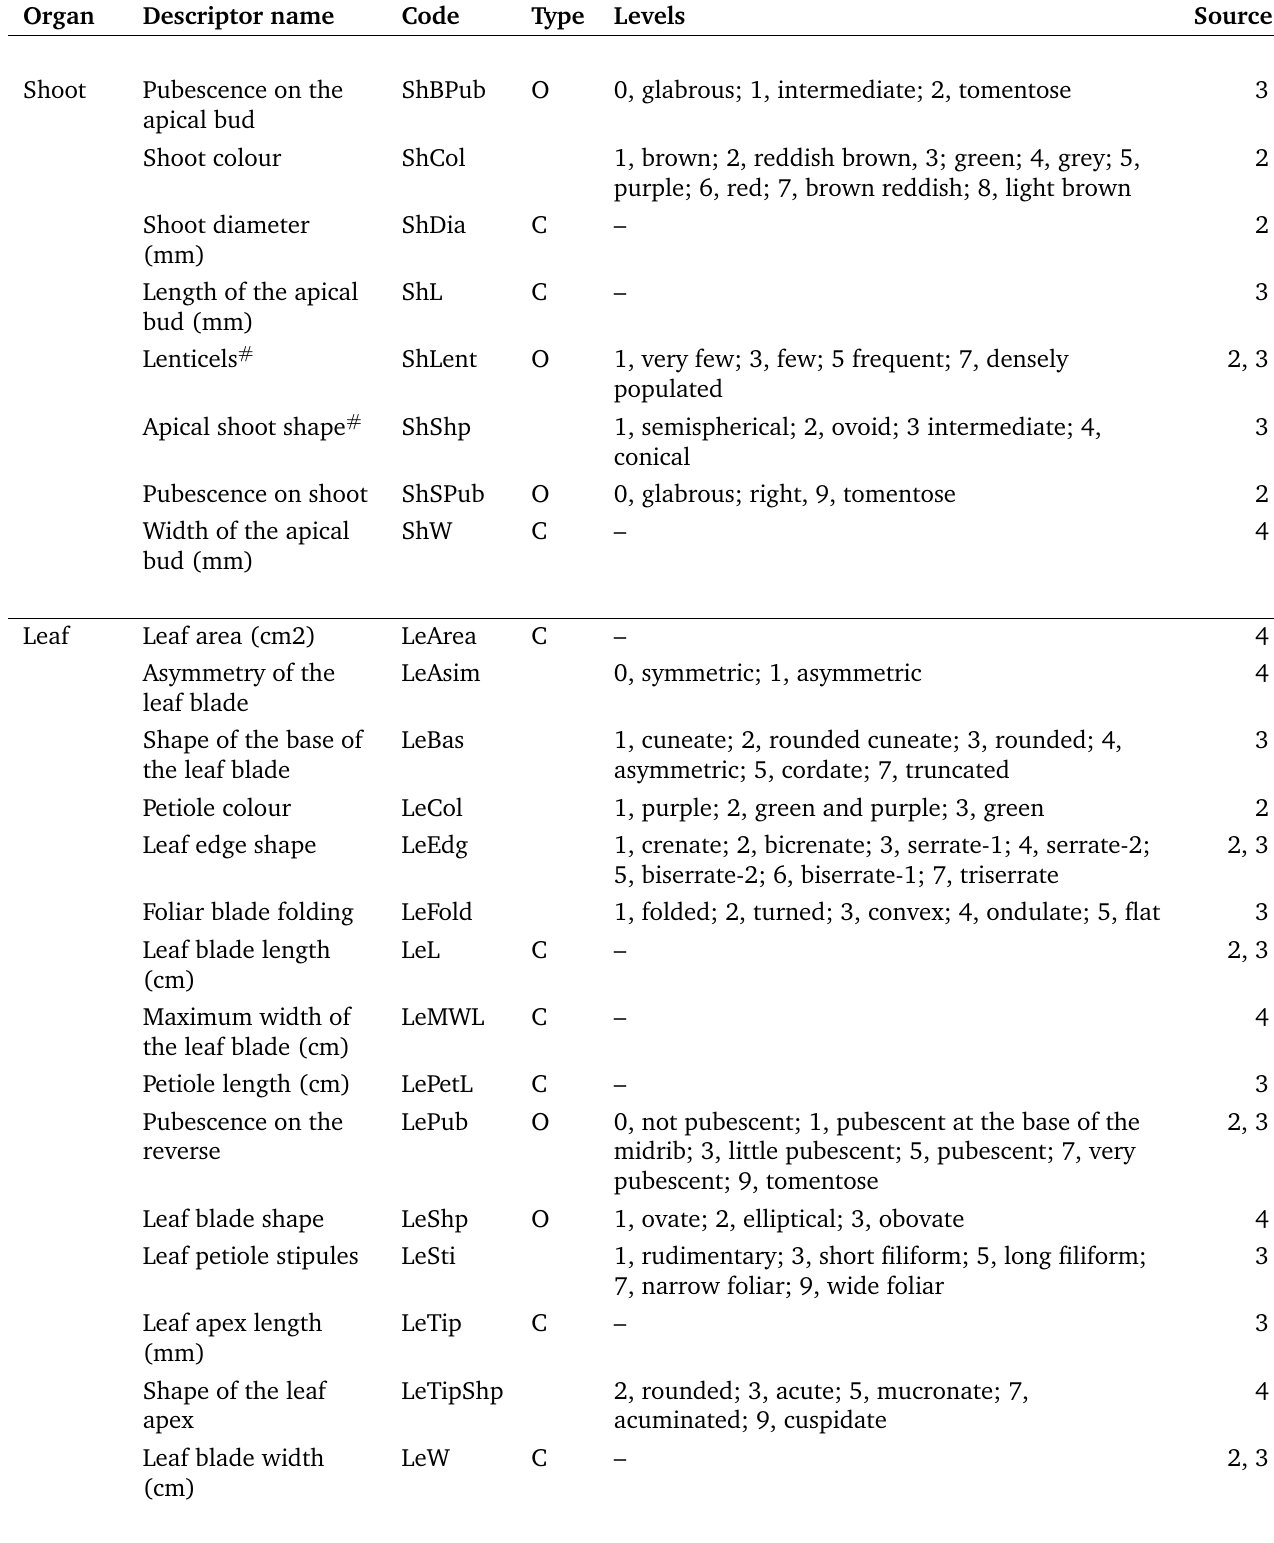
Table 3. Morphological descriptors evaluated in 23 old apple cultivars curated at the IMIDRA collection. Type of descriptor (C, Continuous;D, Discrete; N, Nominal; O, Ordinal). The hash (#) indicates that the descriptor has been altered (by adding or removing some levels of the published descriptors). Sources:1, IBPGR (1982); 2, UPOV (2005); 3, Urbina and Dalmases (2014); 4, this